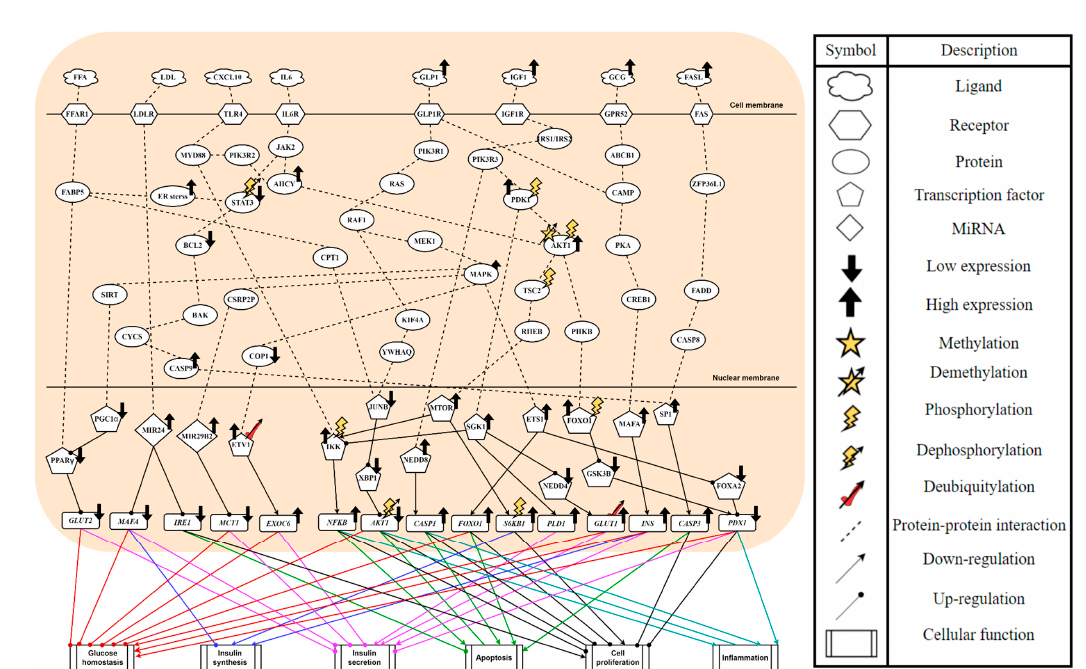
Figure A4. The core signaling pathways of T2D based on our result for investigating the T2D genetic and epigenetic molecular mechanism. The gene regulations and protein interactions were constructed on the basis of the edges in T2D core GWGENs. The cellular functions caused by target genes are clustered with solid lines in different colors. The bold arrowhead marks in black denote the relatively low and high expression in T2D pathogenic signaling pathways in contrast to non-T2D.Appendix B.